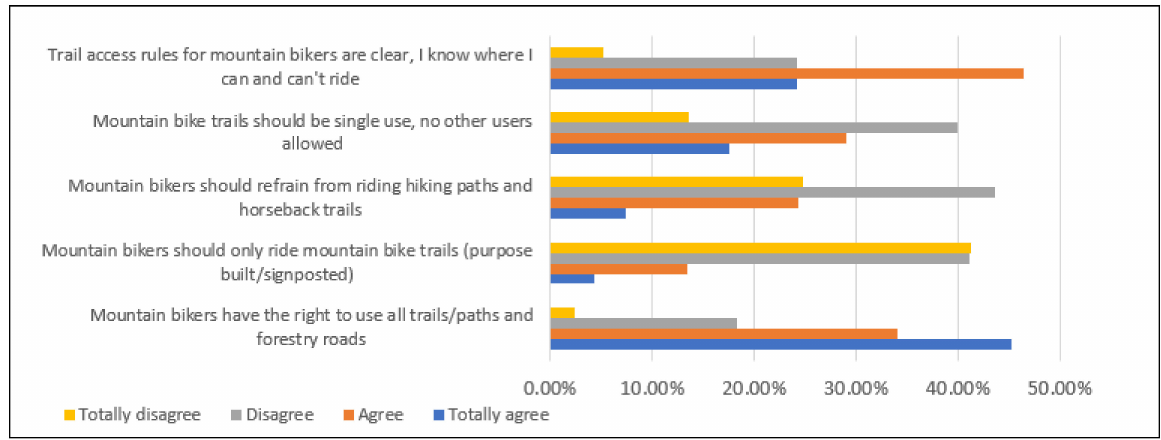
Figure 2. Attitudes towards trails access.